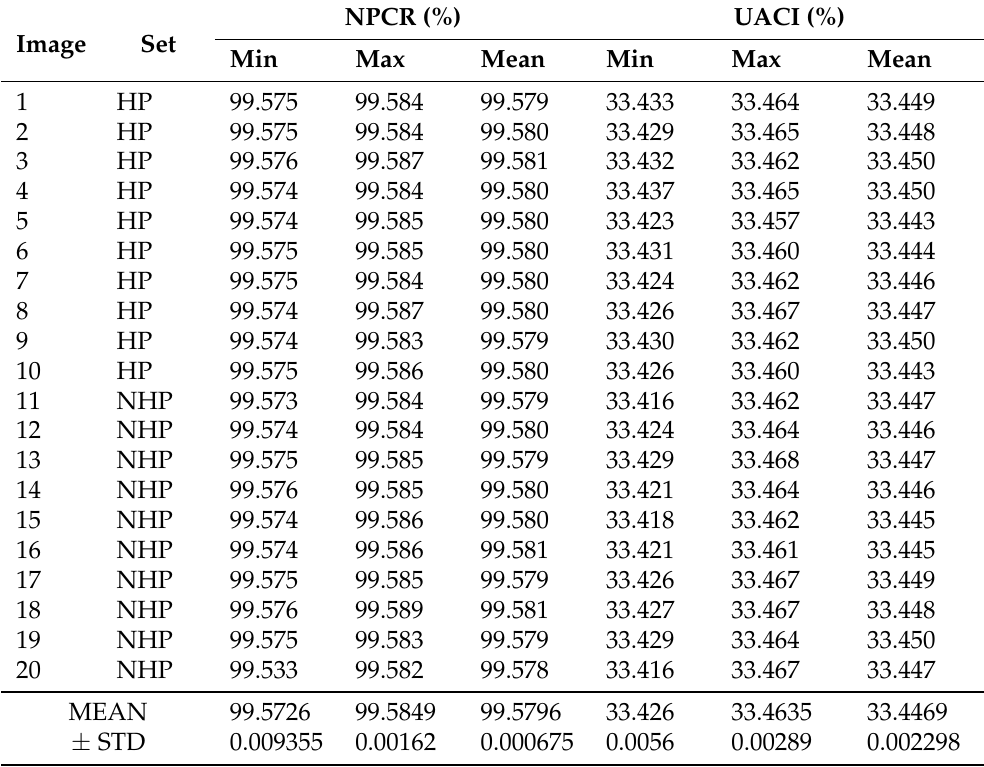
Table 1. Results for NPCR and UACI values both for healthy (H) and non-healthy (NH) patients. NPCR